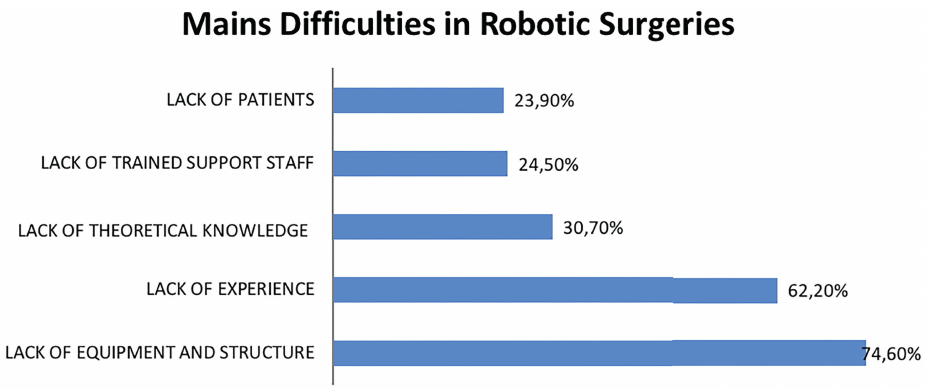
Figure 4 - Mains diffi culties in robotic